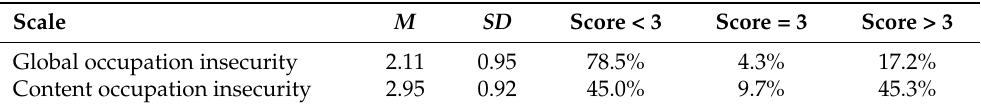
Table 6. Average, standard deviation, and percentage of the number of participants scoring lower, equal, and higher than